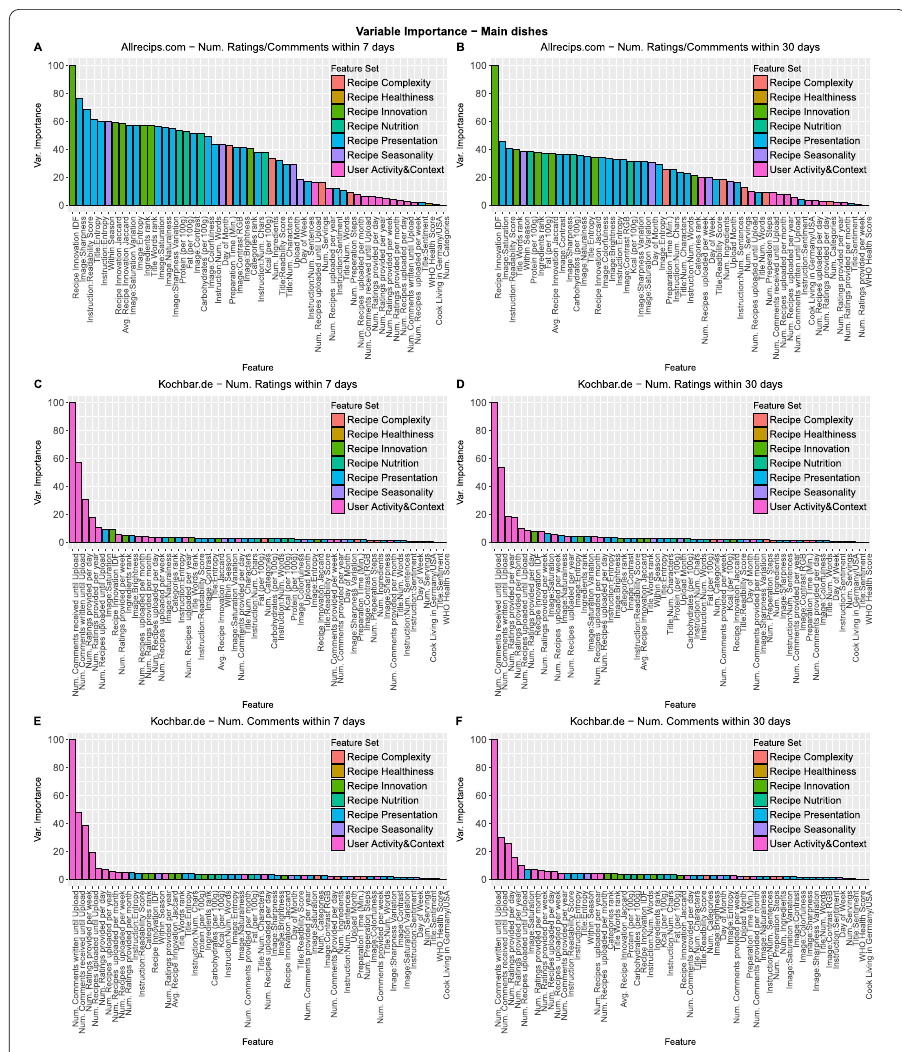
Figure 9 Variable importance for the within one week and month prediction experiments performed on main dishes. Color coding is used to group the features into the 7 feature classes investigated. While it is the features based on ‘recipe innovation’ and ‘presentation’, which are the most important ones in Allrecipes.com, it is the ‘user activity & context’ set, which is the most important one in Kochbar.de. The plots also show that these patterns are rather stable regardless of if we try to predict ratings or comments and whether popularity is measured within a week or within a month time. Comparable patterns are also observed if we